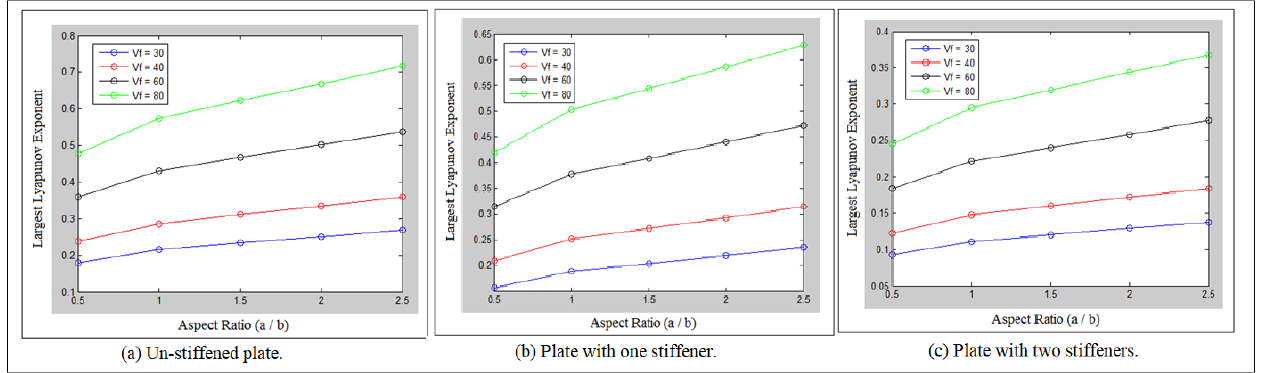
Figure 16. Largest Lyapunov exponent for unstiffened plate and plate with one and two stiffeners.